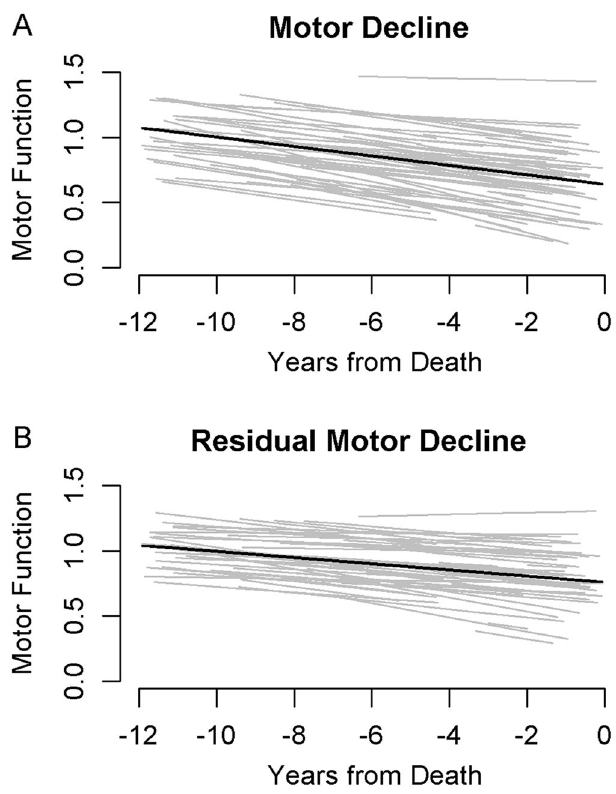
Figure 2. Heterogeneity of motor decline with and without controlling for Alzheimer’s disease and other brain pathologies. We randomly selected a subset of 71 individuals included in the analyses of the full cohort (N = 1226) to illustrate the heterogeneity of motor decline without adjustment for Alzheimer’s disease and other brain pathologies (2A) and for residual motor decline after including terms in the same model which adjusted for indices of ten Alzheimer’s disease and related brain pathologies (2B). ( A ) Trajectories of motor decline based on repeated annual measures of motor testing prior to death (Fig. 1, Model 1a). Each individual light line represents the estimated person-specific decline for a single adult with the length of the line based on the number of years of follow-up. Bold black line represents average motor decline (Estimate slope = − 0.036 standardized unit/year). ( B ) Trajectories of residual motor decline in the same individuals shown in Fig. 2a to illustrate the heterogeneity of residual motor decline after adding terms to the models in 2a for ten indices of brain pathologies. Light lines show person-specific residual motor decline and bold black line represents average residual motor decline (Estimate slope = -0.024 standardized